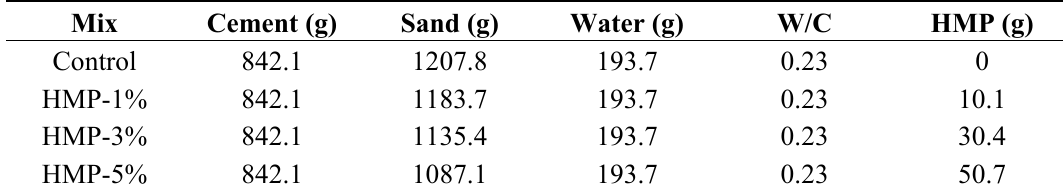
Table 3. Mix proportions of control and HMP